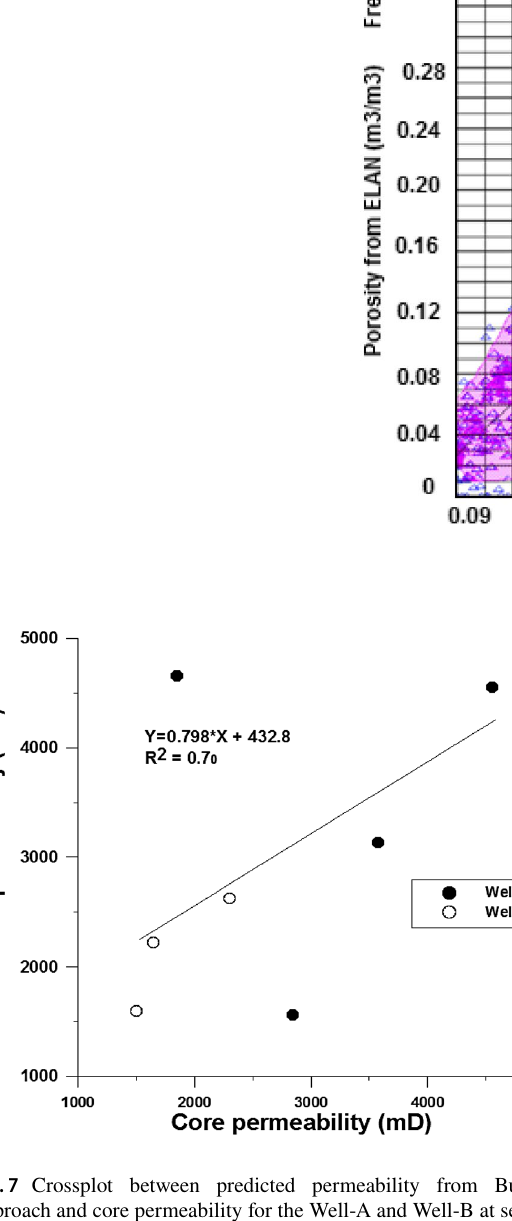
Fig. 6 Crossplot between poros- ity derived from density and ELAN interpretation in Well-B